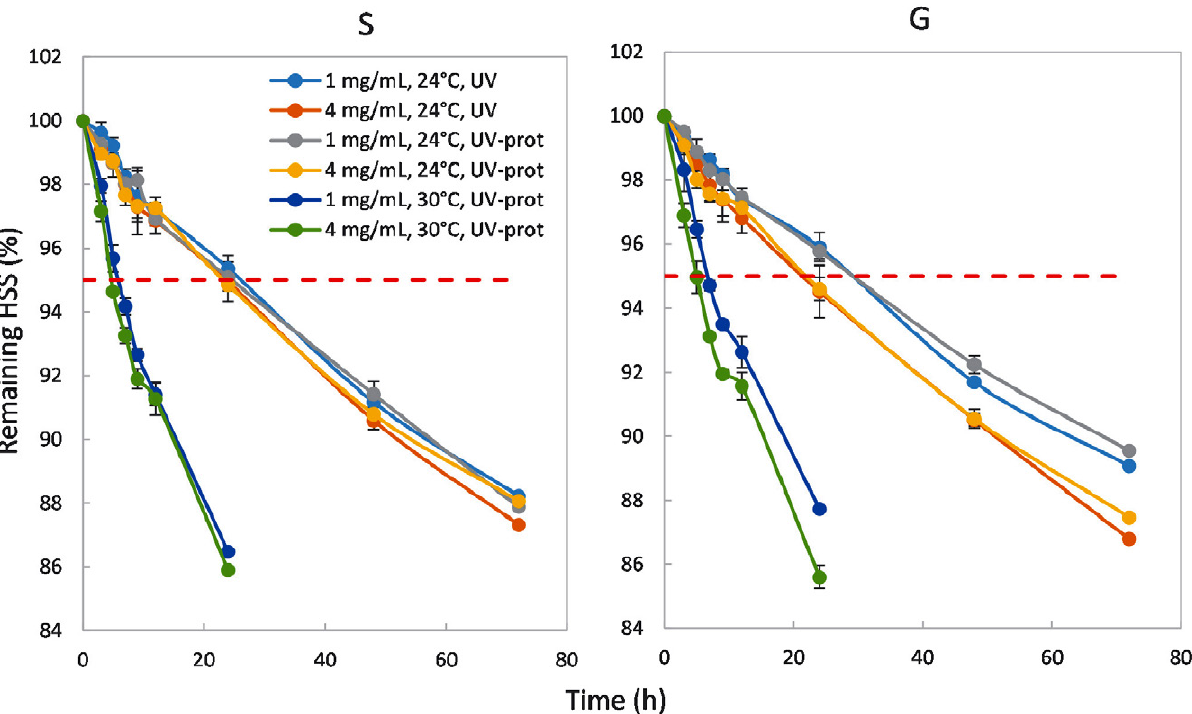
Figure 1. Hydrocortisone sodium succinate (HSS) stability in the simulated solutions for infusion in isotonic saline (0.9% sodium chloride) (S) and 5% glucose solution (G) under different storage conditions. The results are presented as an average ± standard error of the mean, n =